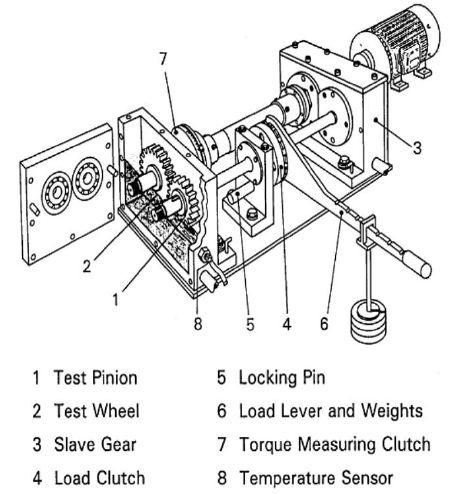
Figure 2. Reference scheme of the 91.5 power-recirculating test rig [50].